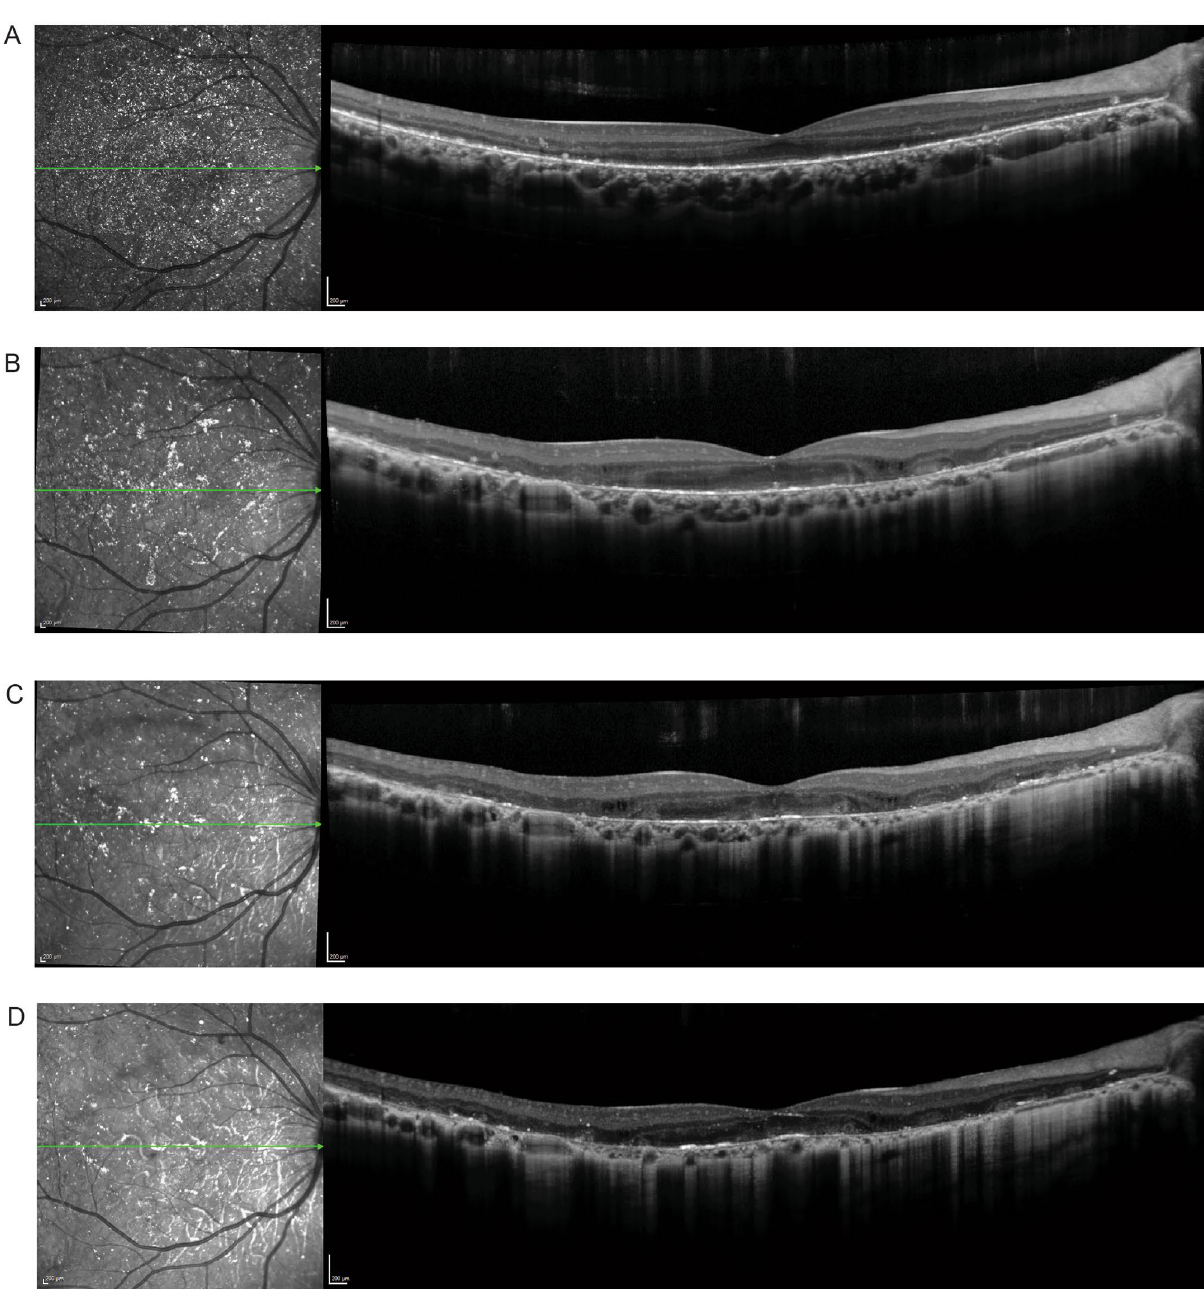
band at the fovea at initial presentation. The horizontal scan through the fovea 3 ( B ), 4 ( C ), and 5 ( D ) years after initial presentation demonstrates disruption and loss of the EZ band, and progressive shrinking of the ONL + area, along with decreased foveolar and choroidal